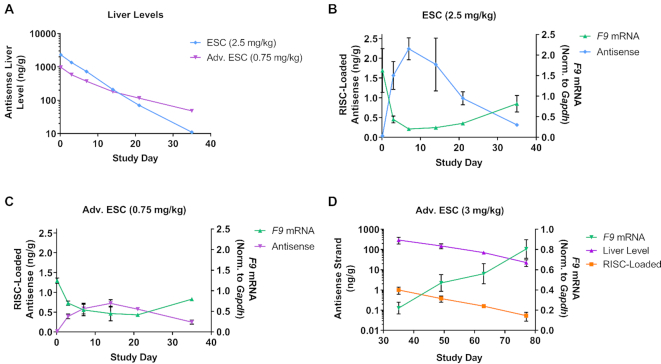
Increased siRNA stability improves knockdown and duration of activity. Cohorts of mice were dosed SC with ESC (2.5 mg/kg, siF9-1) or Advanced ESC (0.75 mg/kg, siF9-2) siRNA targeting F9 (A–C). Animals were sacrificed after 4 hours and on days 3, 7, 14, 21 and 35 post dose. Antisense siRNA levels (μg/g, μg antisense strand per gram of liver) were measured from total liver (A) and plotted on a log10 scale. RISC-loaded antisense siRNA levels were also measured (ng/g, ng of antisense strand per gram of liver) and plotted for ESC (B) and Advanced ESC (C) siRNAs. F9 mRNA knockdown was quantified and normalized to Gapdh for all samples (B, C). Data is represented as mean ± SD, for N = 3. Similar results were obtained with siRNAs targeting Factor 7 (F7, Supplementary Figure S2). (D) Cohorts of mice were dosed with Advanced ESC (siF9-2, 3 mg/kg) siRNA targeting F9. Animals were sacrificed on days 35, 49, 63 and 77 post dose. Antisense siRNA liver levels were plotted on a log10 scale alongside RISC-loaded antisense siRNA levels (both shown in ng/g units, ng of antisense strand per gram of liver). F9 mRNA knockdown was normalized to Gapdh for all samples. Data is represented as mean ± SD, for N = 3.